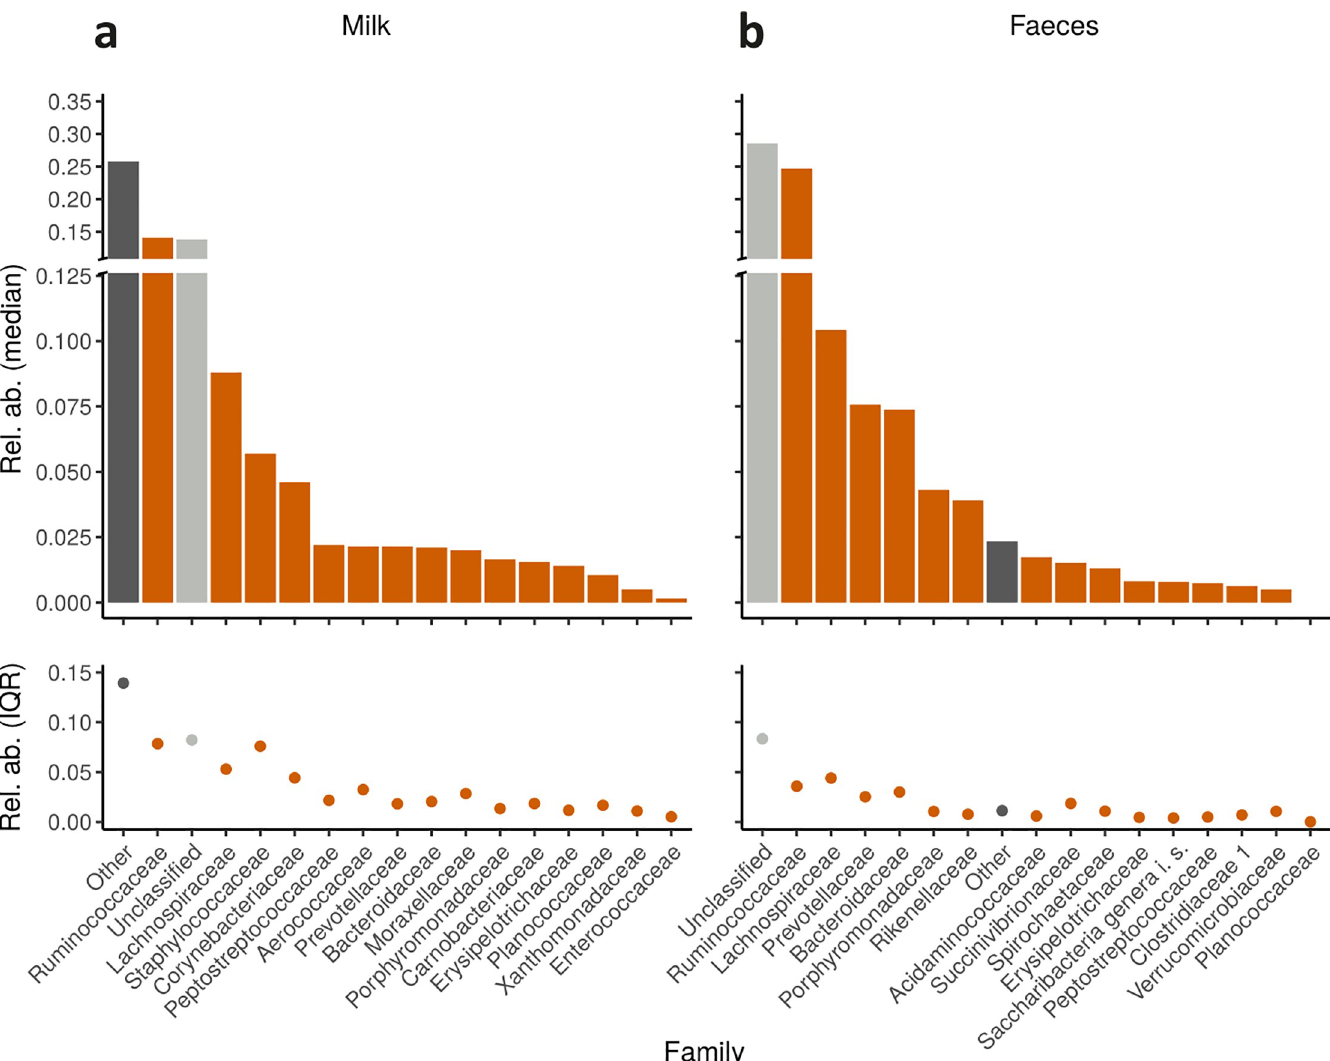
Fig 1. Taxonomic classification by family of raw milk and fecal microbiota from dairy cows. Relative abundances of the most abundant families of Alpine dairy cow raw milk (a) and fecal (b) samples. Median relative abundances are represented in the upper panels, while their variability expressed as interquartiles (IQR) are shown in the lower